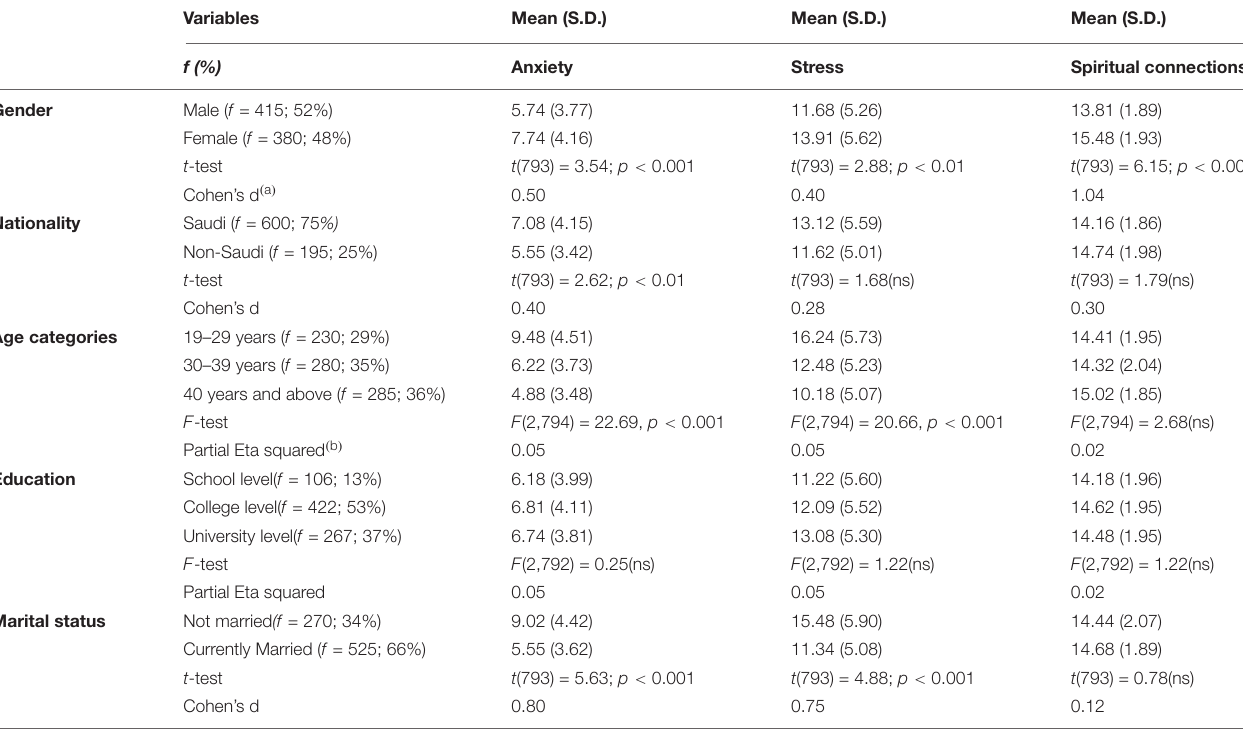
TABLE 1 | Percentage values, mean scores, and significance of mean differences across background variables ( n = 795). Variables Mean (S.D.) Mean (S.D.) Mean (S.D.)